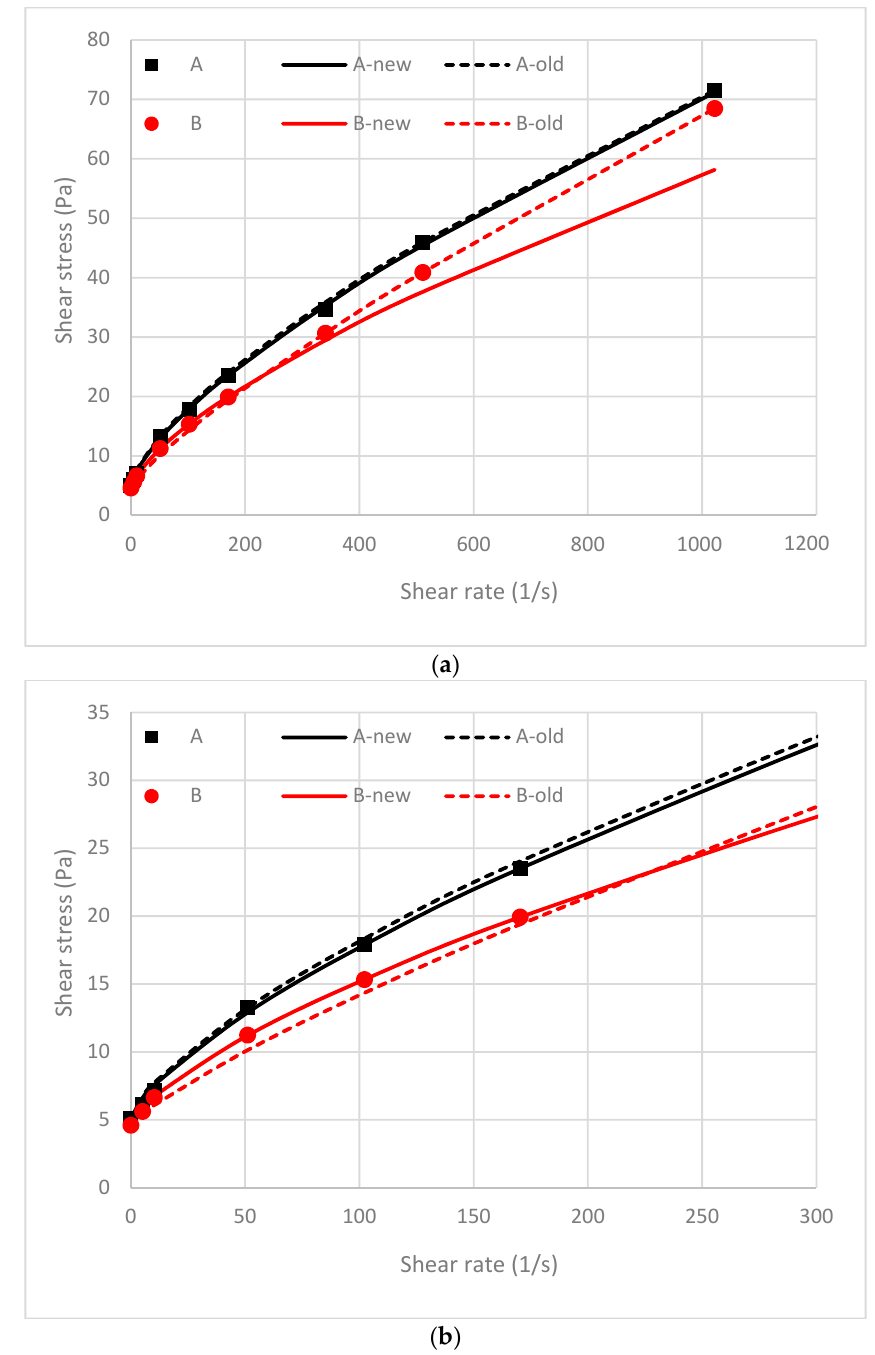
Figure 4. Flow curves of drilling fluids A and B. (a) Upper figure – Full shear rate range; (b) Lower figure – Relevant shear rates.